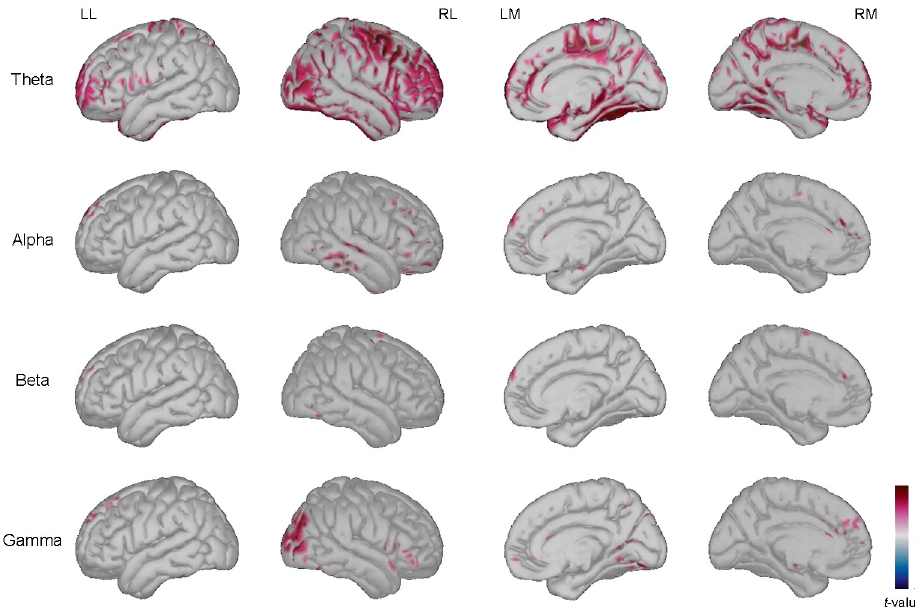
Fig 7. Significant difference between power for later remembered items vs. forgotten items during stimulus presentation for retrieval task. The t -values of the power over theta, alpha, beta, and gamma bands when comparing later remembered items to forgotten items at 700–1,000 ms during the presentation of the stimulus (two-tailed paired t -test, p < 0.05 with Bonferroni correction). LL = left lateral view; RL = right lateral view; LM = left medial view; RM = right medial view.